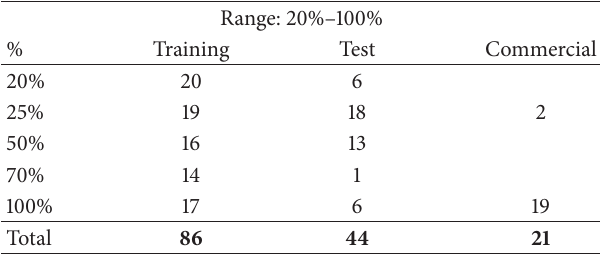
Table 1: Samples with high concentration.